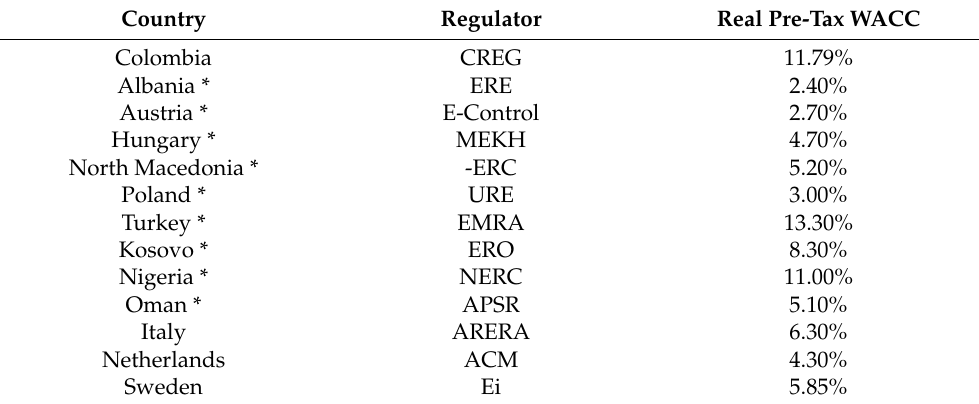
Table 1. Real pre-tax WACC for TSOs in